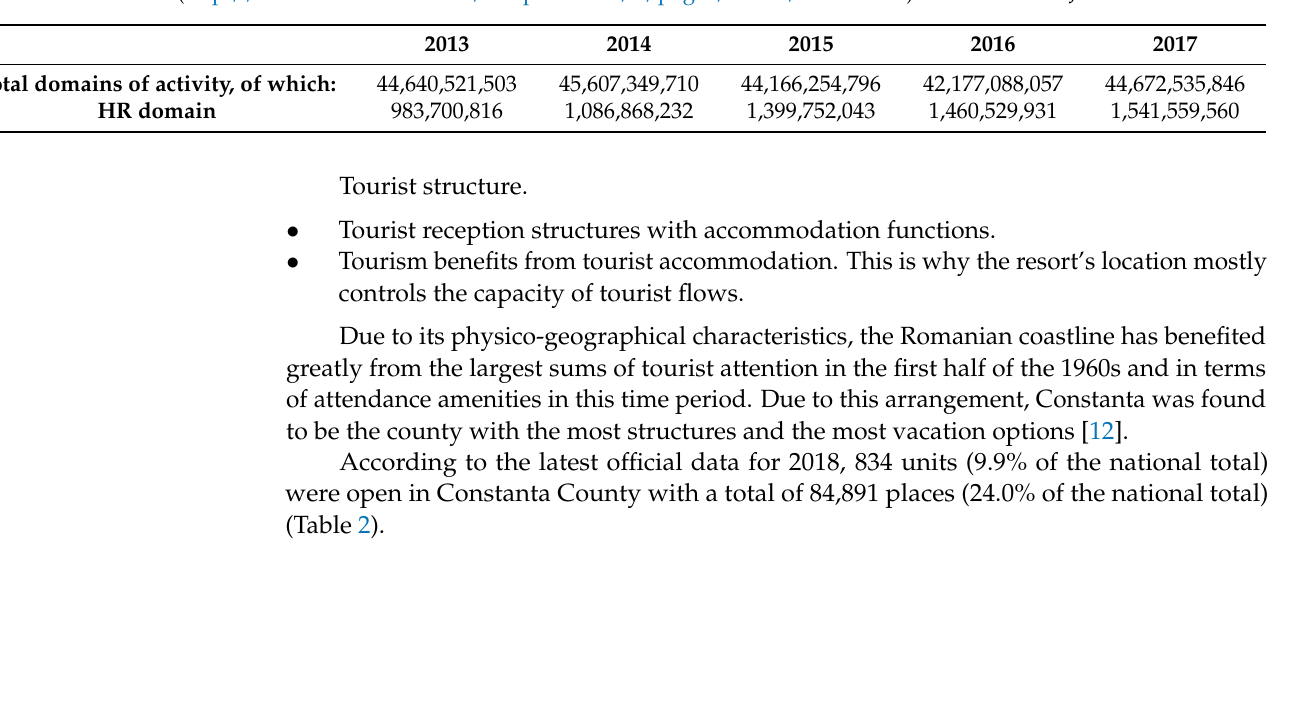
Places Units Places